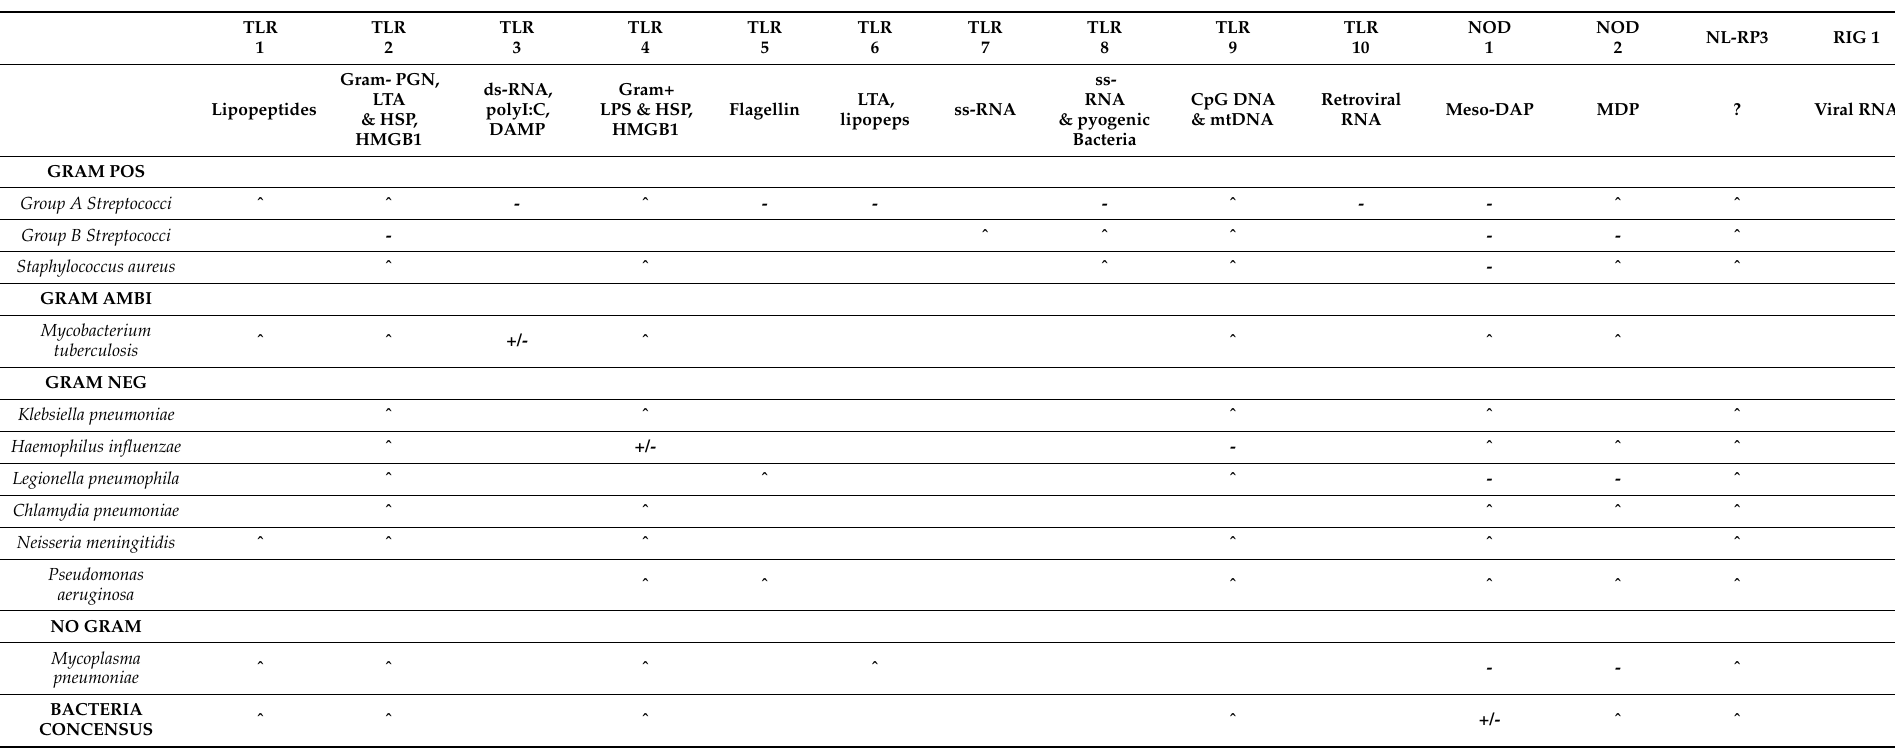
Table 3. Summary of studies quantifying the increased activation or protein expression of TLR and NLR for innate immune system cells following bacterial infections associated with severe COVID-19, ALI/ARDS and/or sepsis. Blank squares indicate that no data were found regarding the activity or expression pattern of the receptor. GRAM POS = Gram-positive bacterium, GRAM AMBI = bacterium that yields ambiguous Gram staining, GRAM NEG = Gram-negative bacterium and NO GRAM means that Gram staining is irrelevant. – indicates no change, ˆ indicates increased activation or protein expression, V indicates downregulation or decreased protein expression, +/- indicates conflicting reports about whether there is increased activity or protein expression, -/V indicates conflicting reports about whether there is no change or downregulation and a blank square indicates no available information. PGN = peptidoglycan; LTA = lymphotoxin alpha; HSP = heat shock protein; HMGB1 = High Mobility Group Box 1 protein; dsRNA = double-stranded ribonucleic acid; polyI:C = polymer composed of inosine and cytosine; DAMP = damage-associated proteins; Gram+ = expressed by Gram-positive bacteria; lipopeps = lipopolypeptides; ssRNA = single-stranded ribonucleic acids; CpG DNA = deoxyribonucleic acid high in cytosine and guanine, typifying a microbial genomic origin; mtDNA = deoxyribonucleic